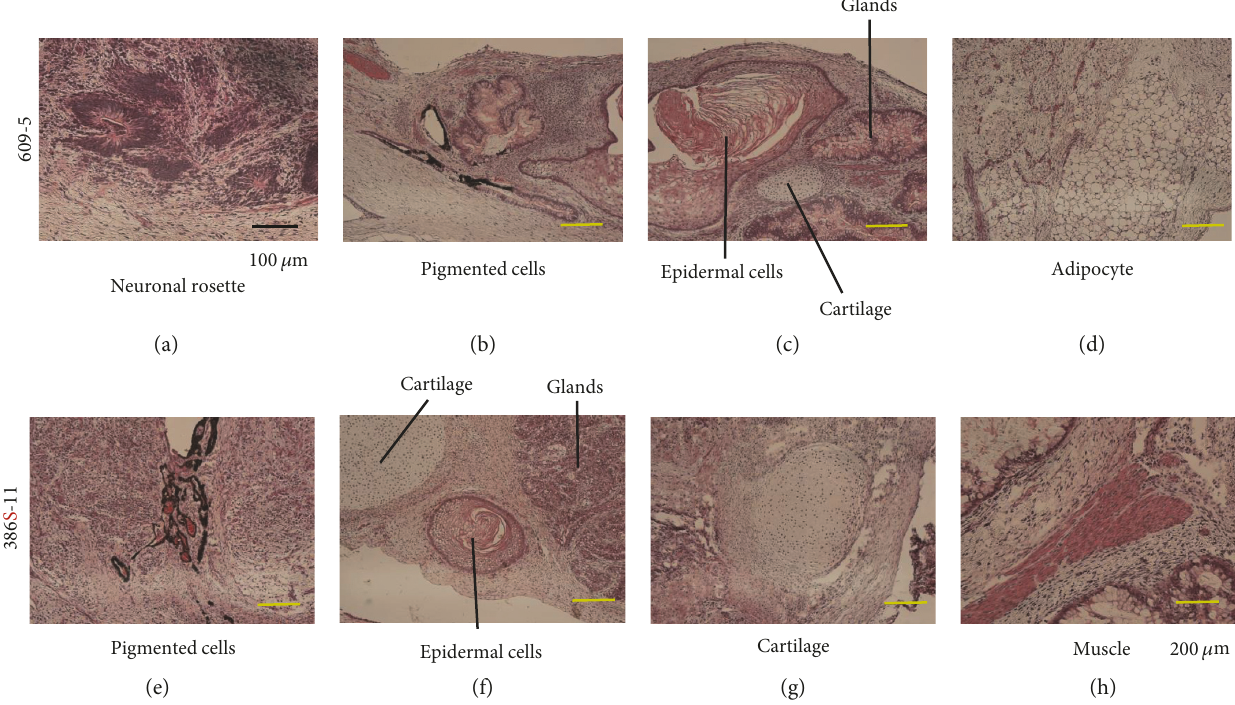
Figure 2: In vivo di ff erentiation of 609-5 iPS cells (XX) and 386S-11 (XXX) iPS cells. Six months after transplantation into the testes of NOD/ Scid mice, hiPS cells (609-5: (a – d), 386S-11: (e – h)) had formed teratomas, including mesodermal tissues (adipocytes, cartilage, and muscle), endodermal tissues (mucus-producing epithelium), and ectodermal tissues (neuronal rosette, epidermal cells, and pigmented